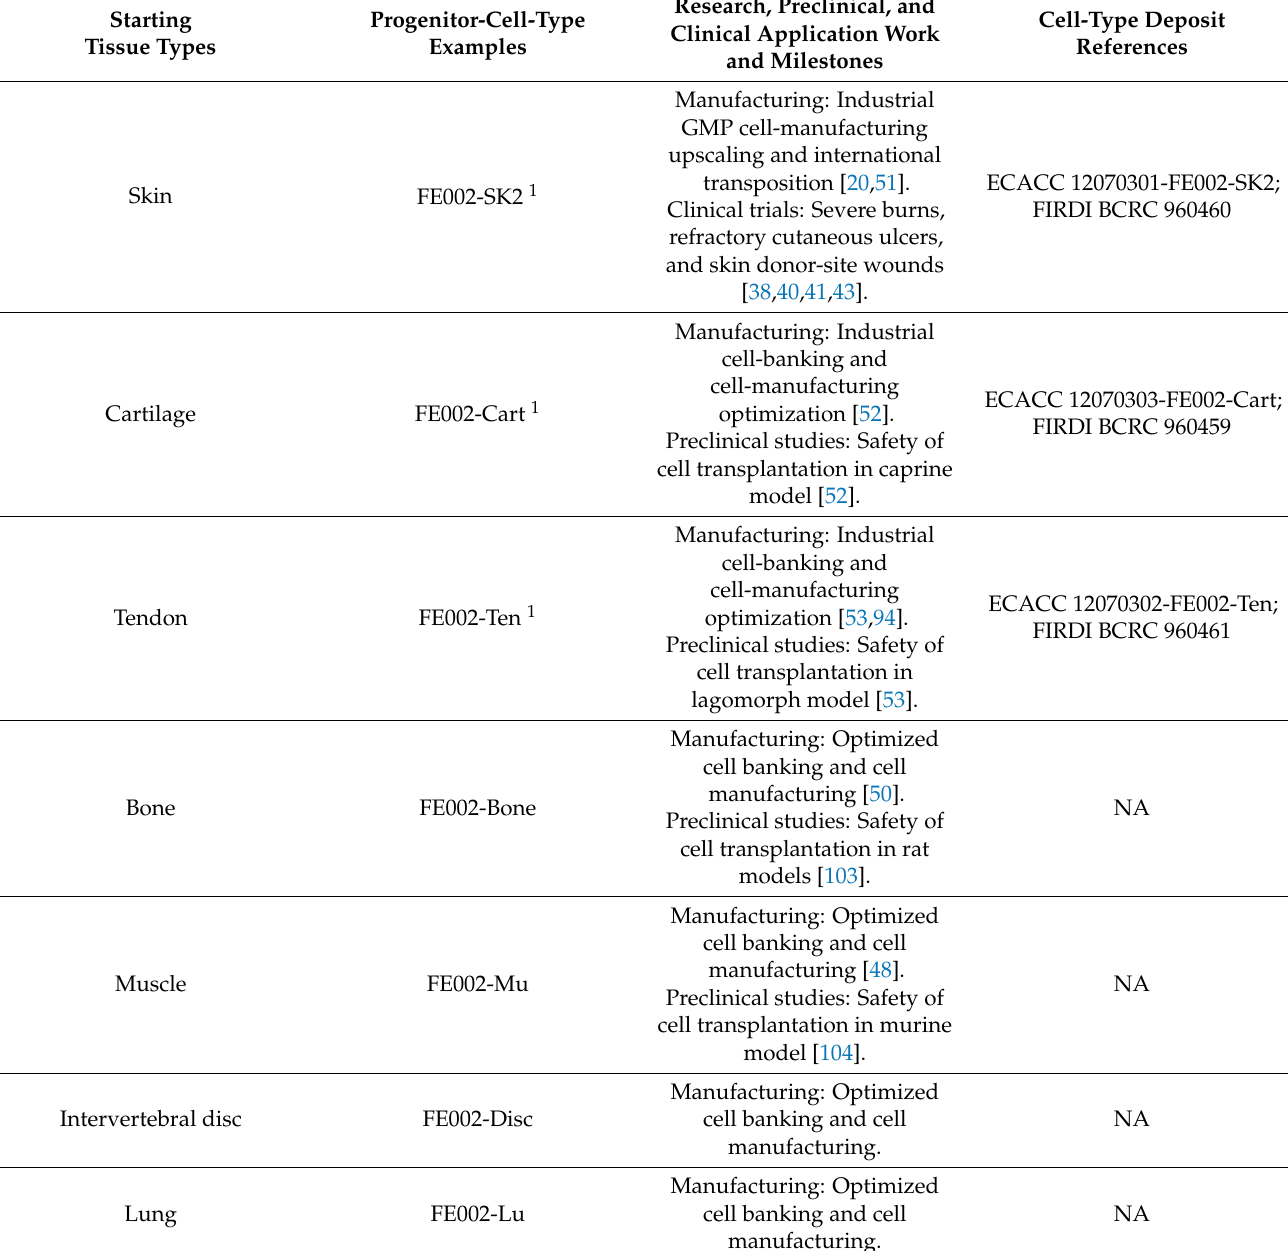
Table 6. Overview of the various tissue-specific homologous applications considered or investigated at preclinical and clinical stages under the Swiss progenitor-cell-transplantation program [1]. It may be noted that initial transposition of FE002-derived progenitor-cell sources to GMP manufacture were performed in collaboration and under contract with BioReliance in the UK (Merck group, Glasgow and Stirling, UK). Therefore, in view of GMP cell banking for API manufacture, most of the control and testing schemes were based on requirements existing for vaccine substrates, such as presented in Table 2. ECACC, European collection of authenticated cell cultures; FIRDI, Food industry research and development institute; GMP, good manufacturing practices; NA, non-applicable; UK, United